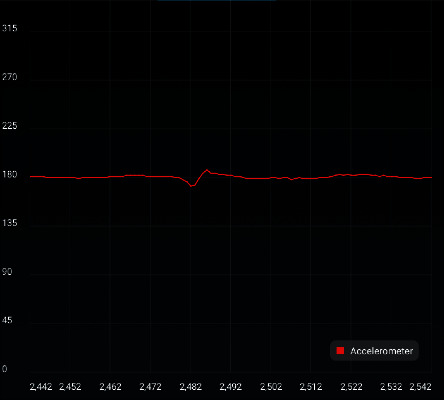
Acceleration curve.